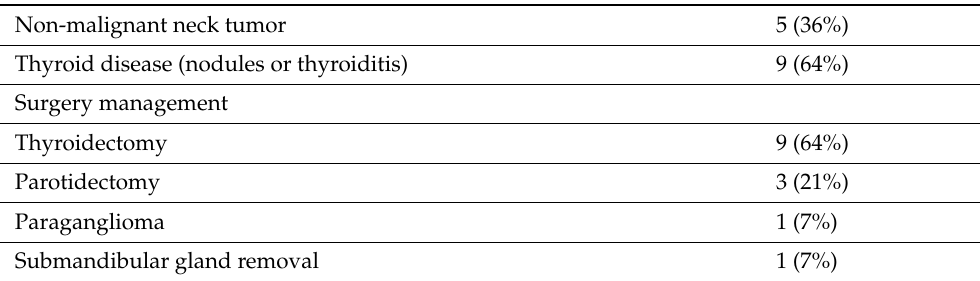
Table 3. Clinical characteristics of the control